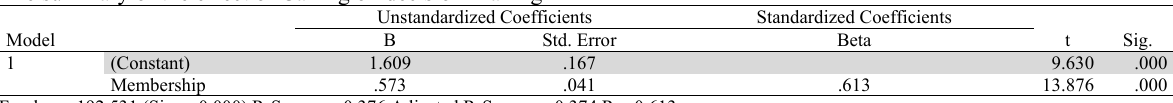
The summary of the effect of Calling on decision-making